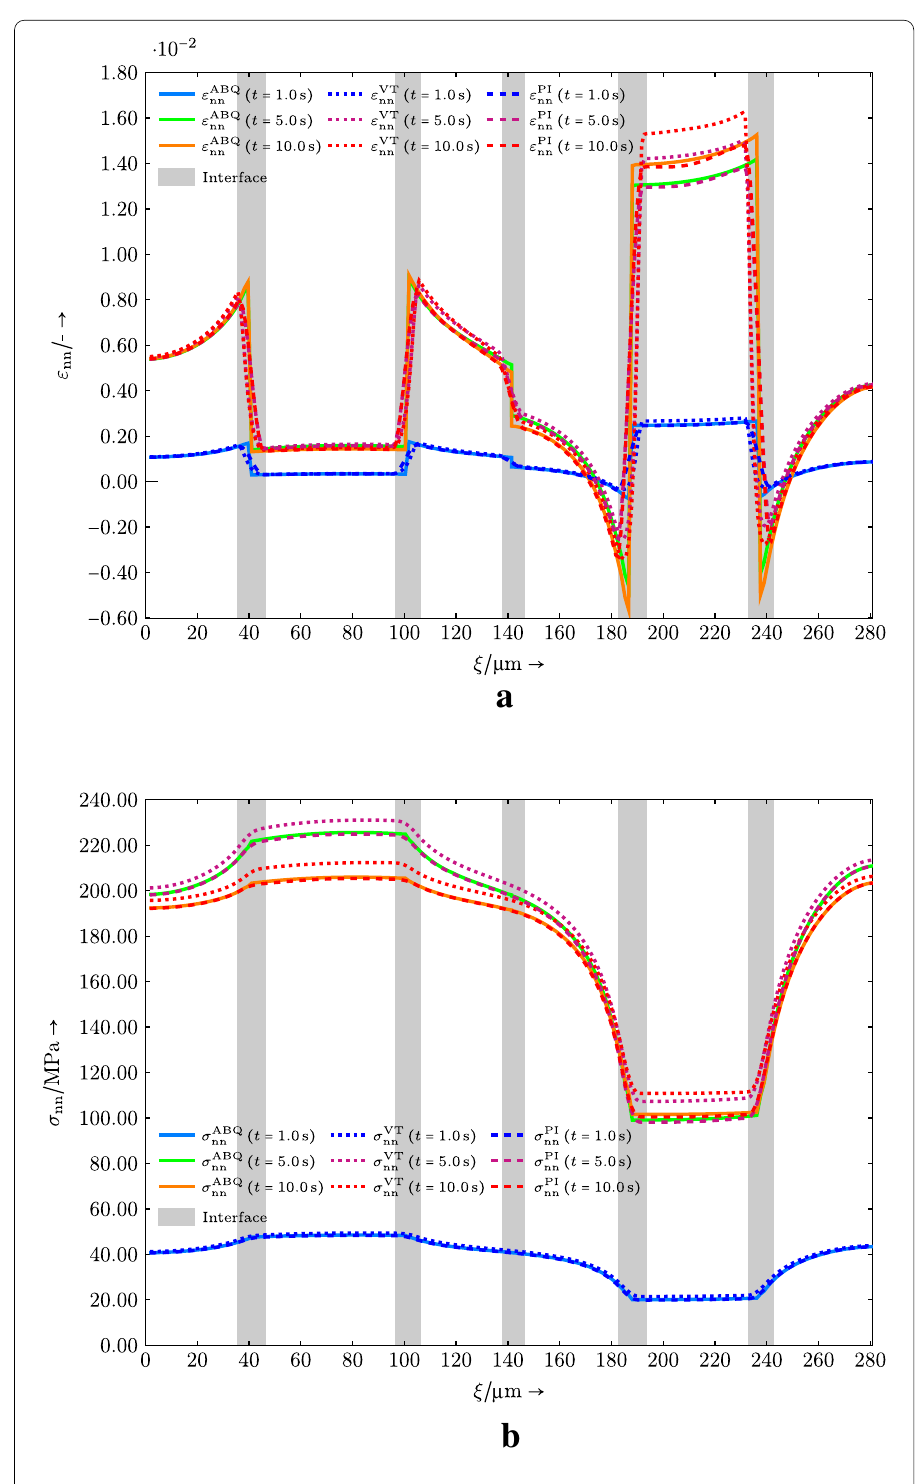
Fig. 14 Results for a ε nn and b σ nn along ξ (whole diagonal): comparison of nn-components of the VT and the PI approach to the sharp-interface solution. Three different times ( t = { 1 . 0 , 5 . 0 , 10 . 0 } s) are plotted along